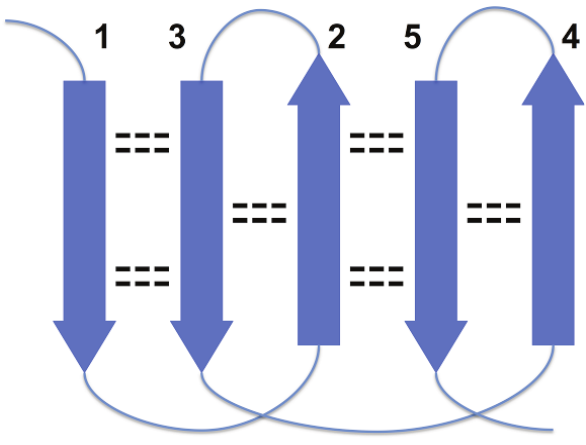
Figure 2. Disallowed arrangement of strands 1, 2 and 3 in a beta sheet because of loops